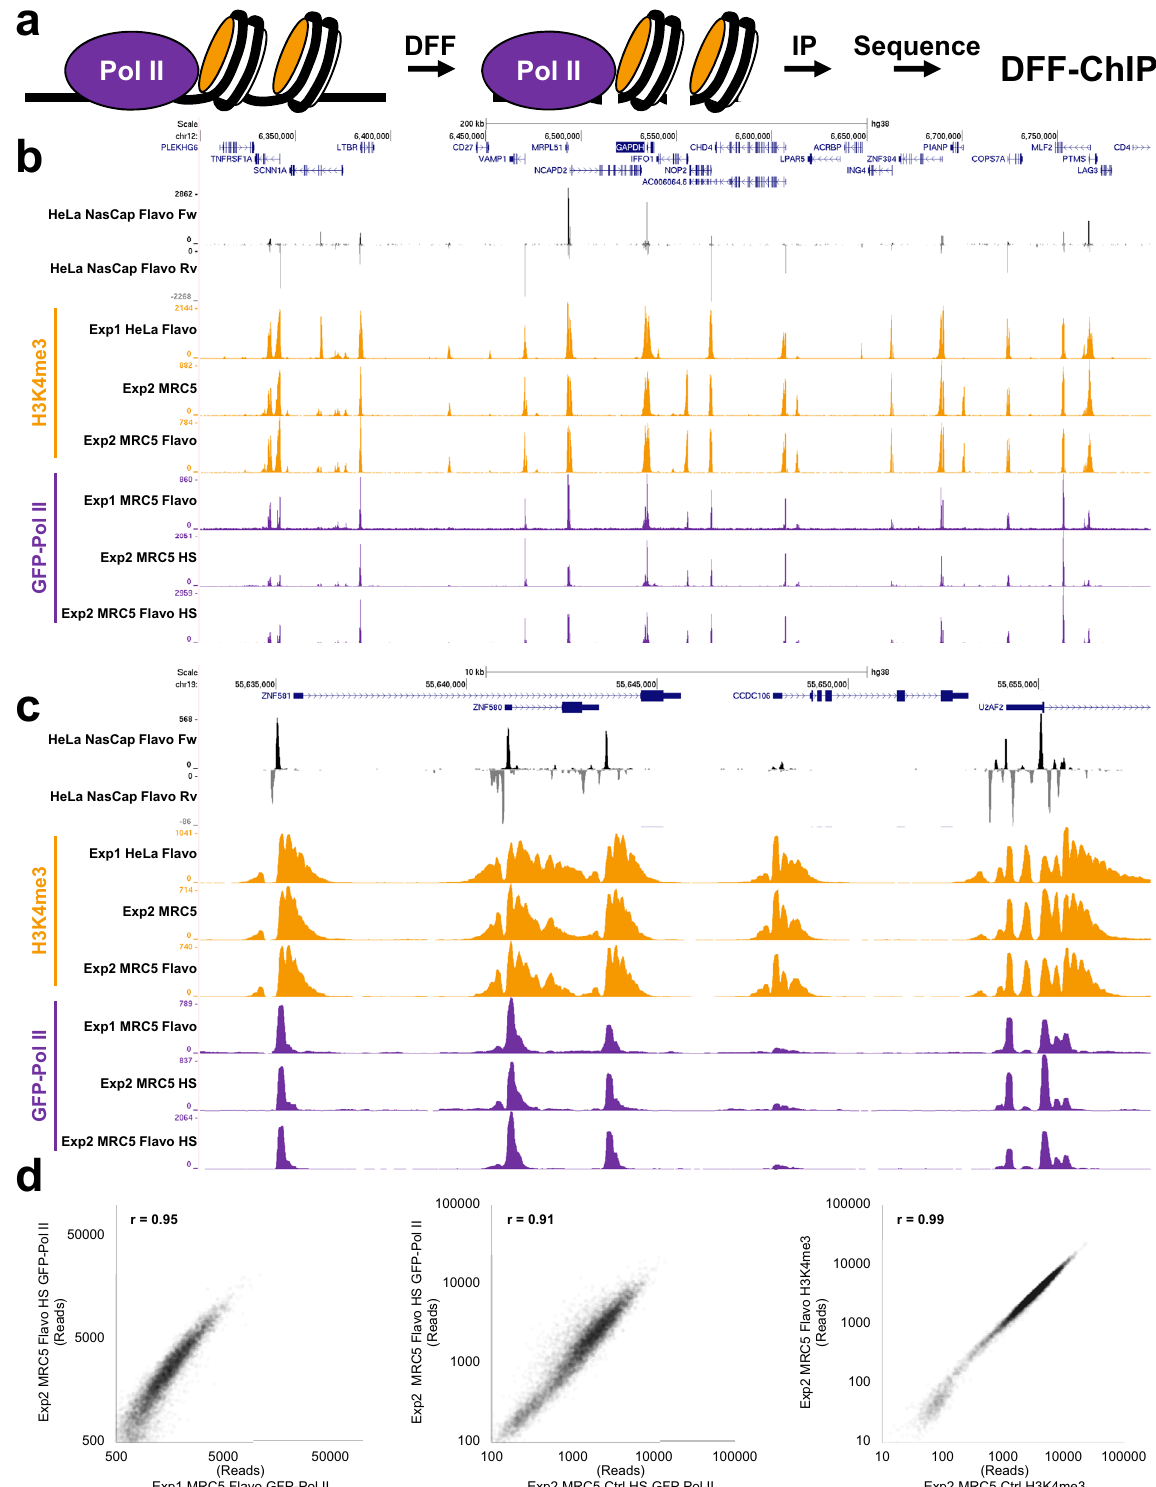
Fig. 1 Reproducibility of Pol II and H3K4me3 DFF-ChIP. a Diagram of the DFF-ChIP method. Nuclei isolated from uncrosslinked cells in the presence of EDTA are digested with DFF and lightly sonicated to release soluble DNA complexes. The complexes are then immunoprecipitated, library prepped, and sequenced. b , c Genome browser tracks of Pol II DFF-ChIP (purple) and H3K4me3 DFF-ChIP (orange) from HeLa and MRC5 GFP-Pol II cells generated in two different experiments (Exp1 and Exp2). HS denotes that samples were washed with high salt. Browser tracks of Flavo NasCap PRO-Seq (black/gray) show transcription data. d Correlation plots of datasets from Exp1 and Exp2. Reads in 10,000bp windows centered on the MaxTSS of 12,229 HFF truQuant promoters were summed and plotted against sums from other datasets. Pearson correlations (r) are